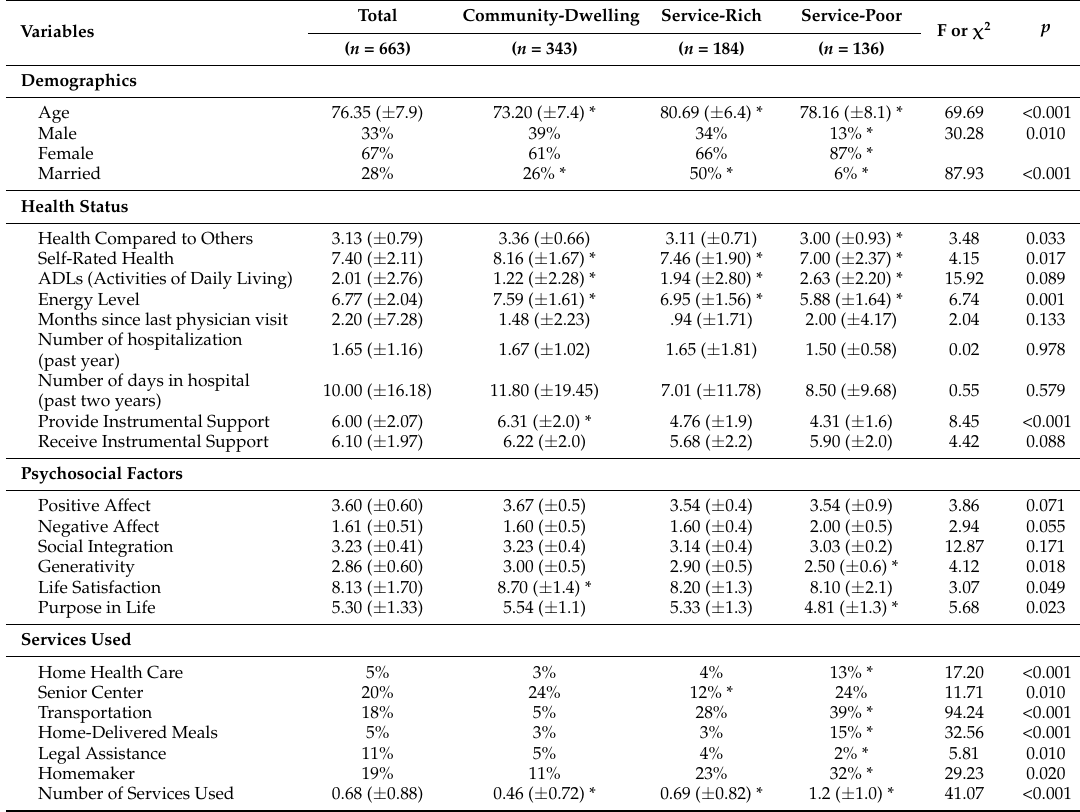
Table 1. Sample characteristics by housing